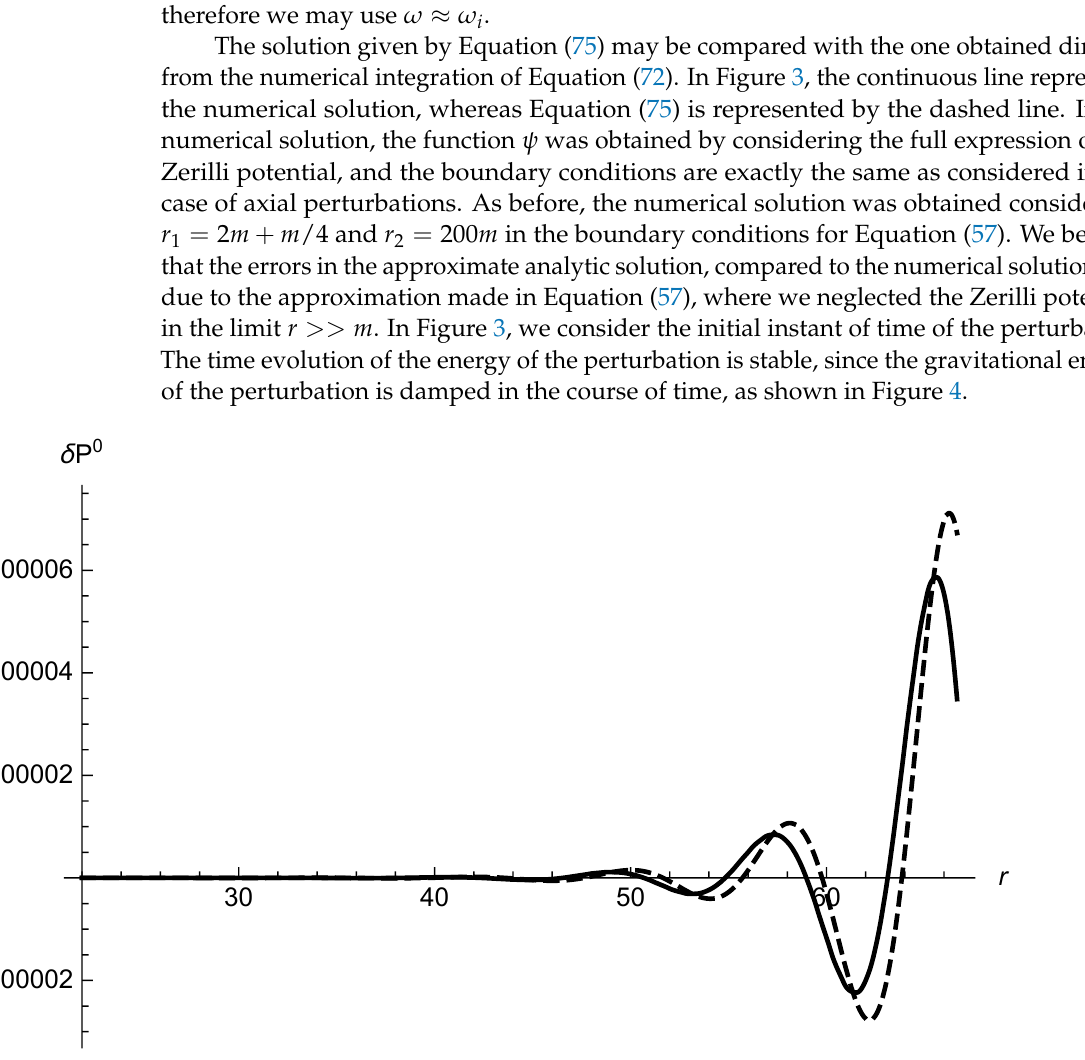
Figure 3. Comparison between the real parts of the gravitational energy of the polar perturbation. The continuous line represents the numerical value of the evaluation, and the dashed line corresponds to the value resulting of the approximate analytic expression (75). The parameters used in the analysis are A = 10 − 6 , m = 1, and the frequency considered is the fundamental one ( n = 0, l = 2) ω = 0.373162 − i 0.089217, obtained by means of the third-order WKB method. The data represent the initial instant of time of the perturbation, i.e., t =